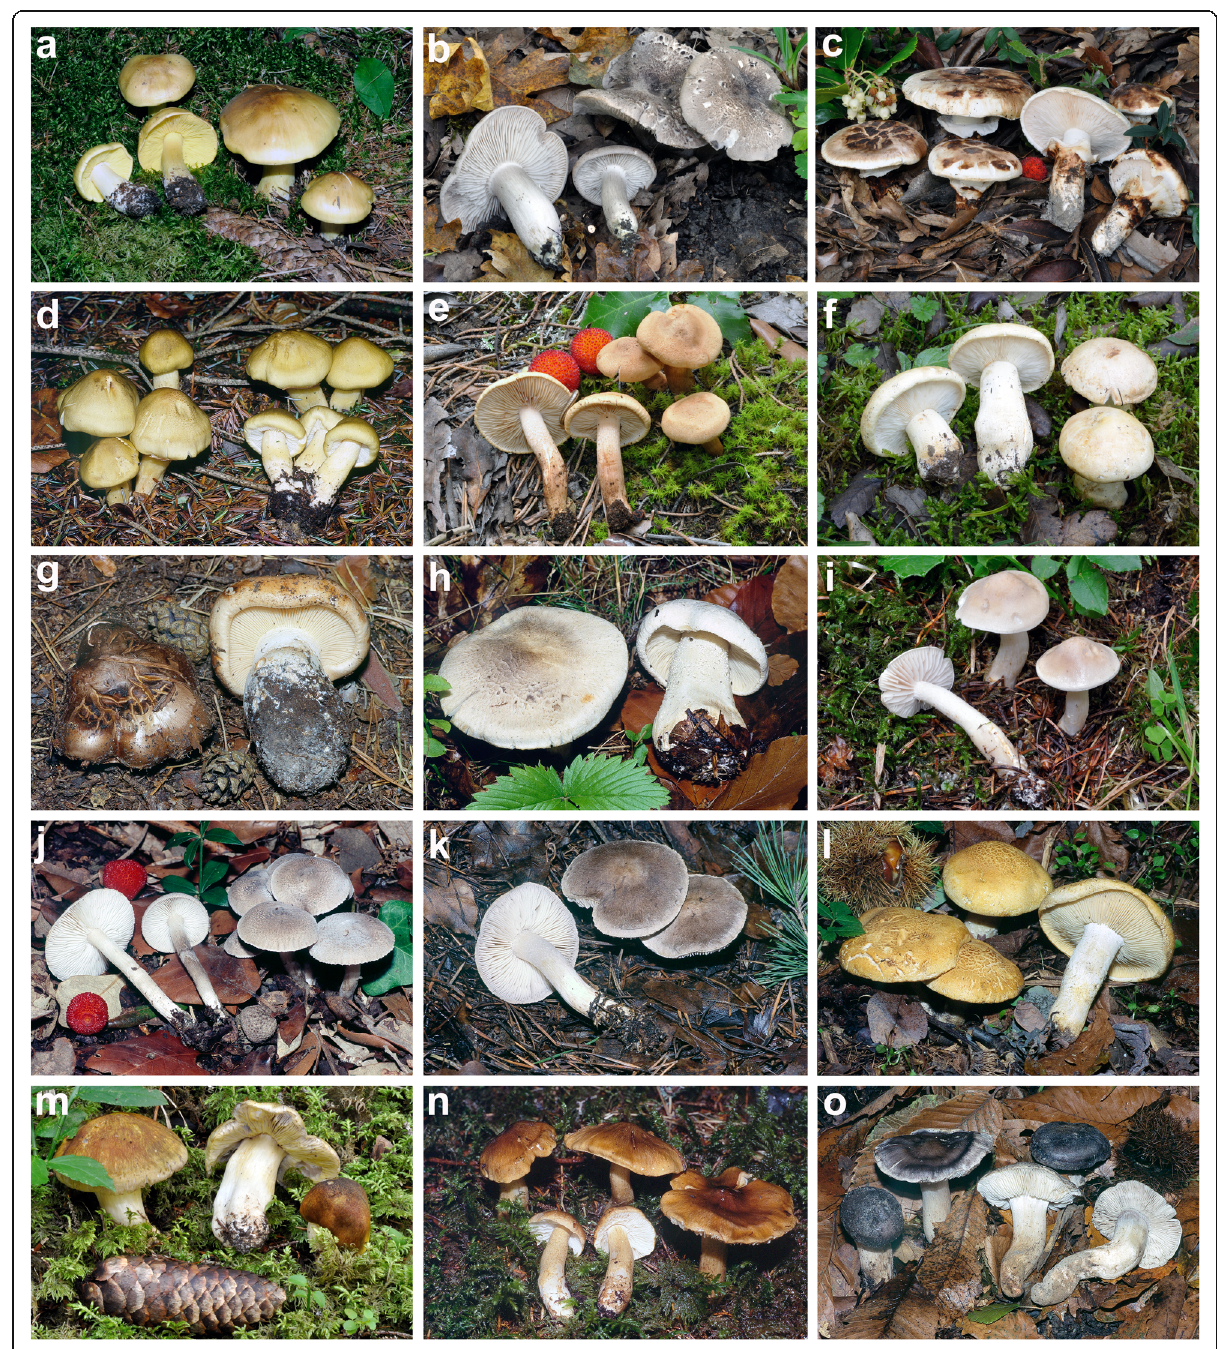
Fig. 1 Tricholoma collections examined. a T. frondosae (AMB 17243) b T . orirubens (AMB 17410) c T . caligatum (AMB 17231) d T . saponaceum (AMB 17433) e T . psammopus (AMB 17411) f T . acerbum (AMB 17177) g T . colossus (AMB 17237) h T . filamentosum (AMB 17248) i T . inamoenum (AMB 17367) j T . ramentaceum (AMB 17423) k T . terreum (AMB 17444) l T . apium (AMB 17203) m T . arvernense (AMB 17215) n T. fucatum (AMB 17300) o T . josserandii (AMB 17407). Photos by G.